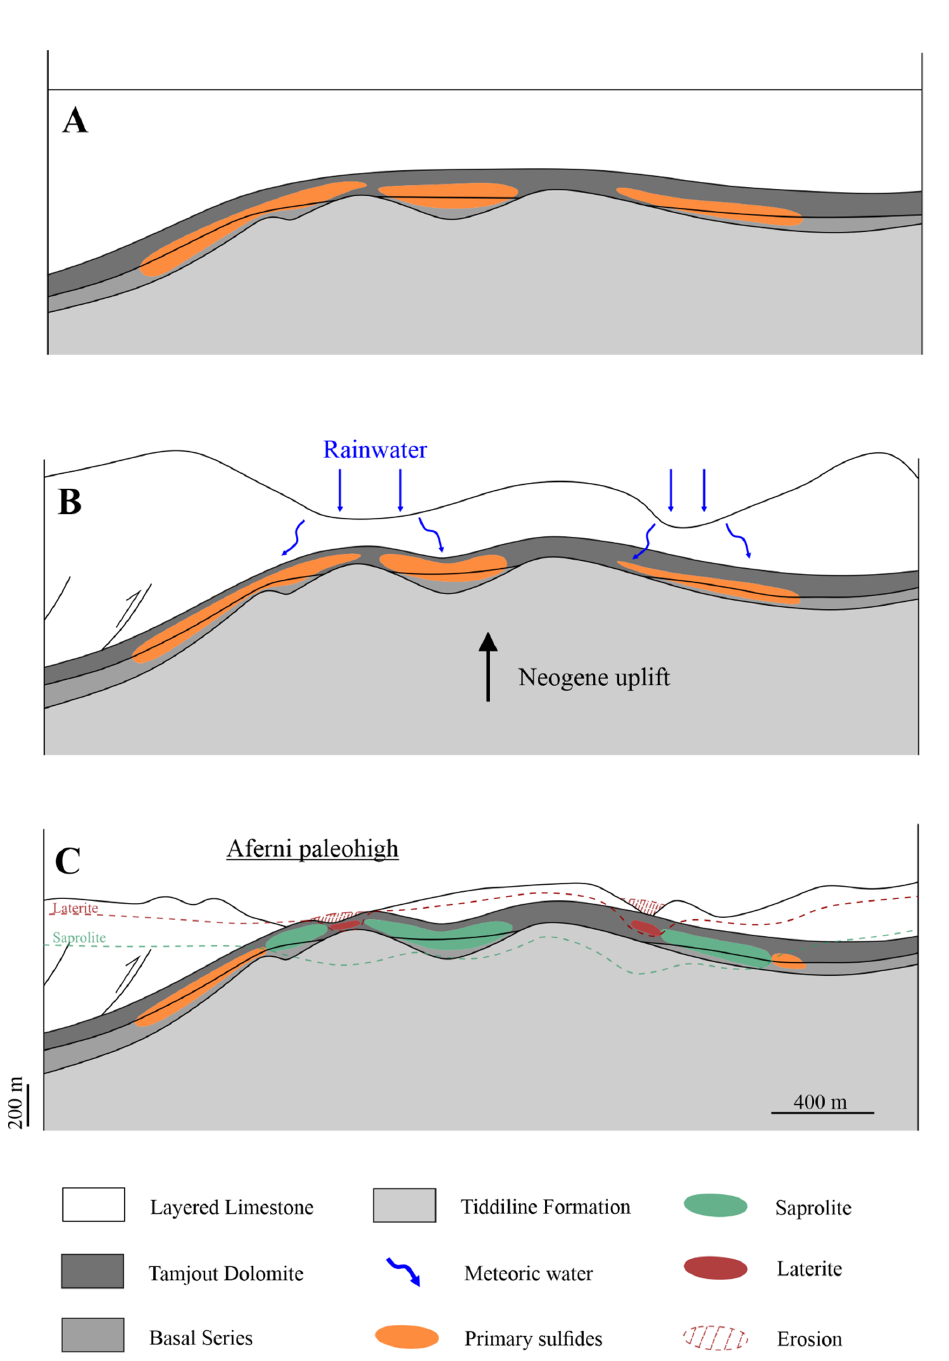
Figure 9. Schematic representation of the weathering model for the supergene Tizert deposit: ( a ) initial situation (pre-~30 Ma), with fresh primary (hypogene) ore well-developed along basin margins adjacent to the basement paleohighs—see reference [4] for details; ( b ) initiation of weathering during Neogene uplift(s); ( c ) current situation, with weathering profile (laterite s.s.–saprolite–primary sulfides) (Modified from reference [4]).